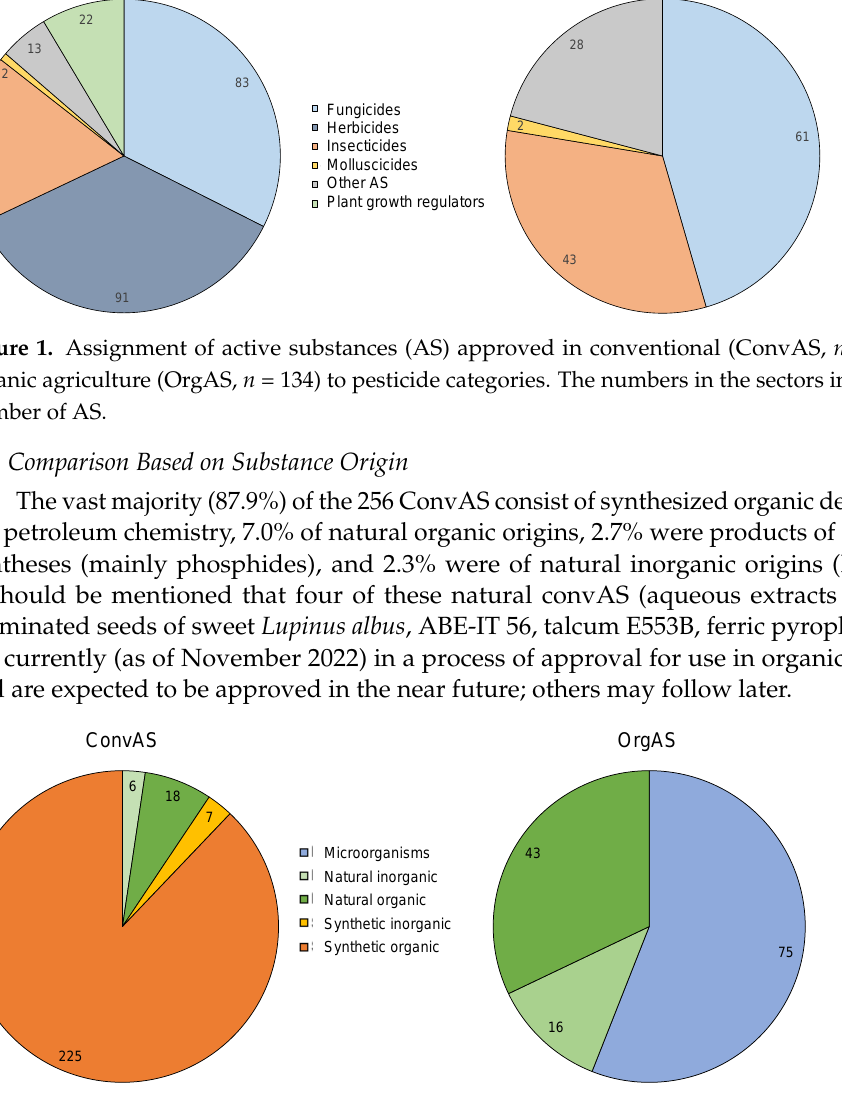
Figure 2. Origin of active substances (AS) approved in conventional (ConvAS, n = 256) or organic agriculture (OrgAS, n = 134) in the European Union. Numbers represent the number of AS of a particular origin class. The numbers in the sectors indicate the number of AS.